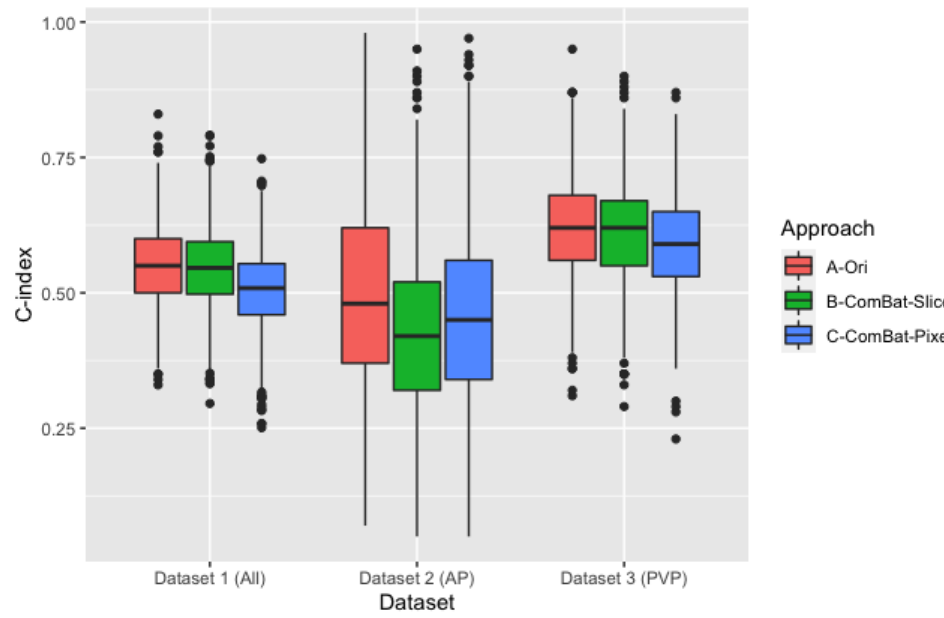
Figure 3. Boxplot comparison of the C-indices before and after ComBat harmonization.